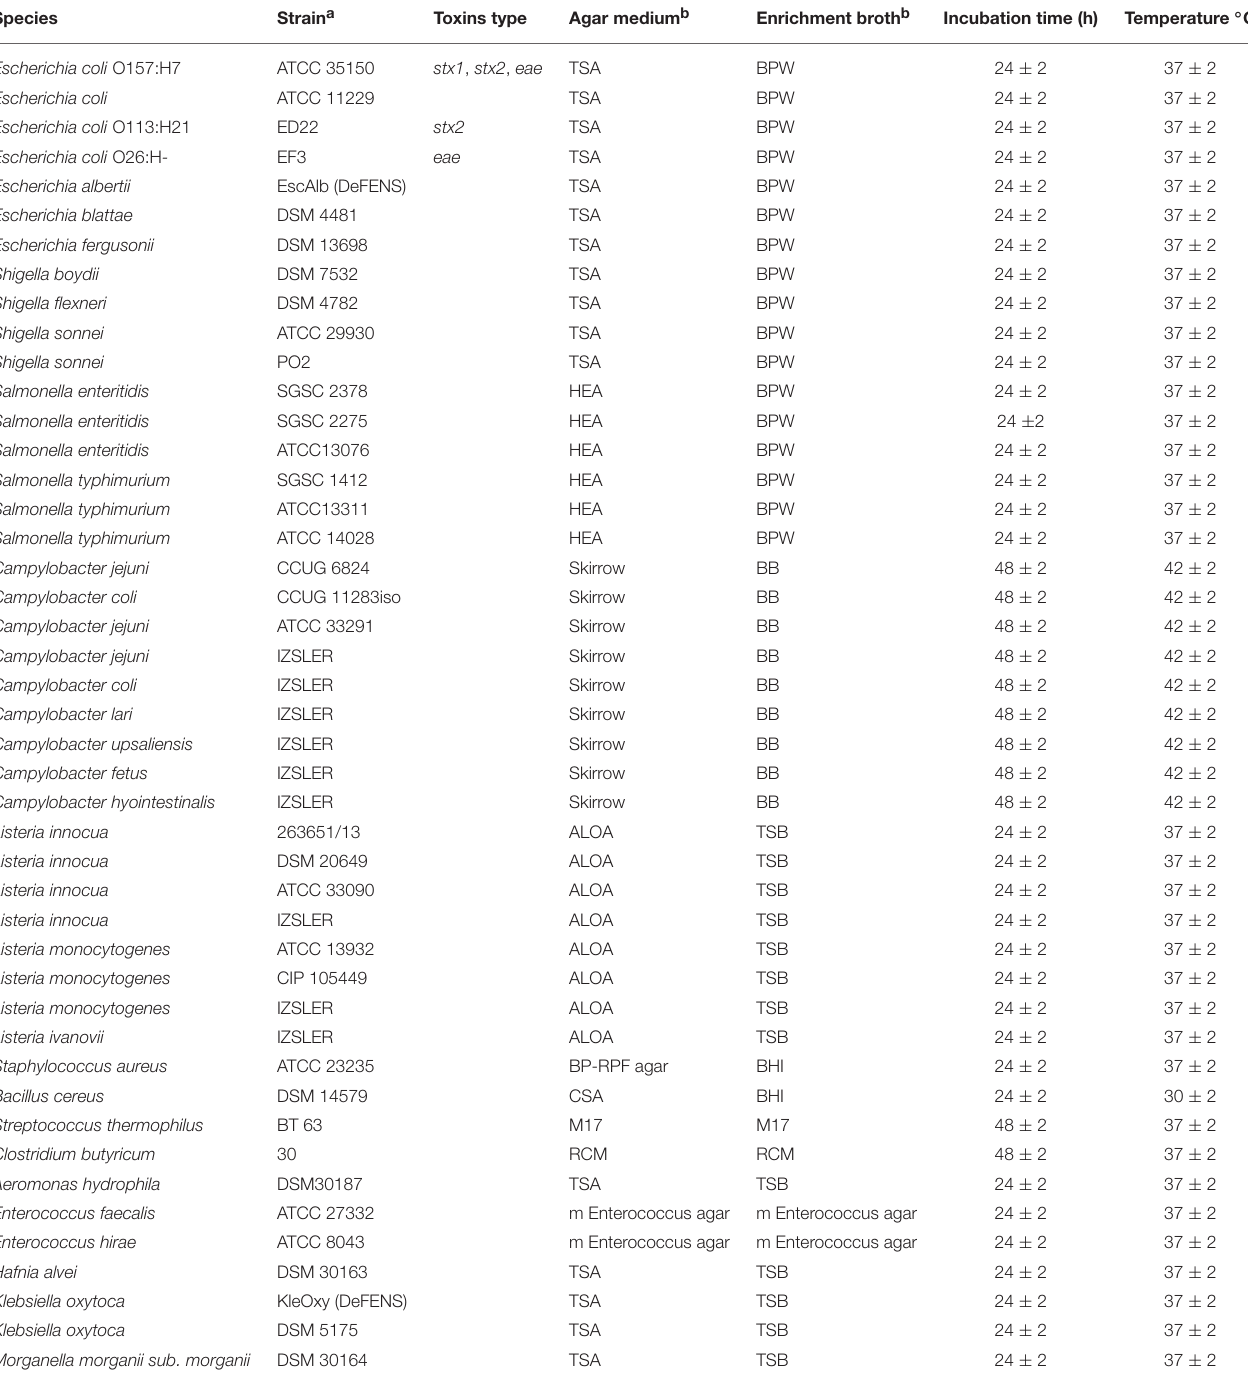
TABLE 1 | List of target and non-target species with growth conditions.